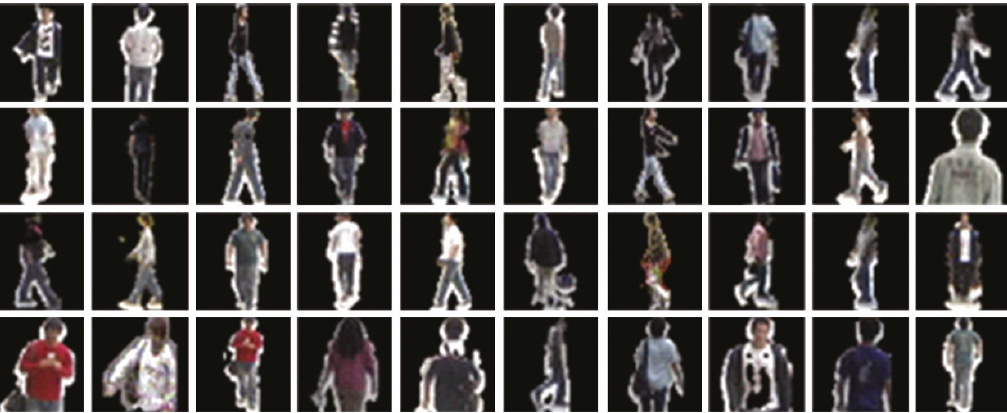
Figure 14: The positive database.